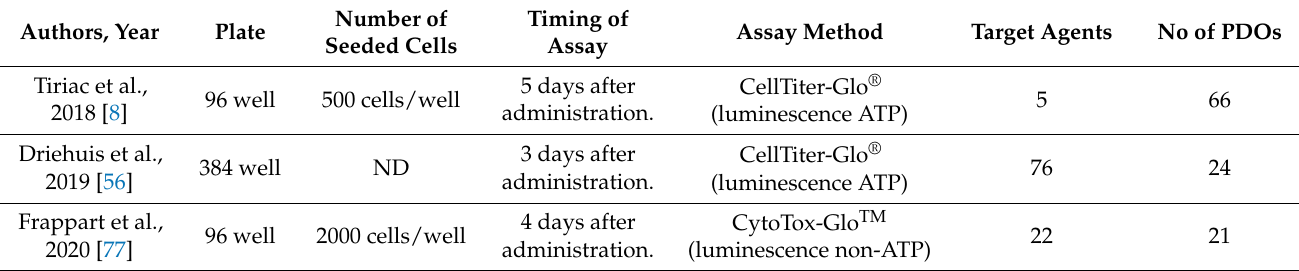
Table 4. Methods of high-throughput drug screens for patient-derived organoids (PDOs) of